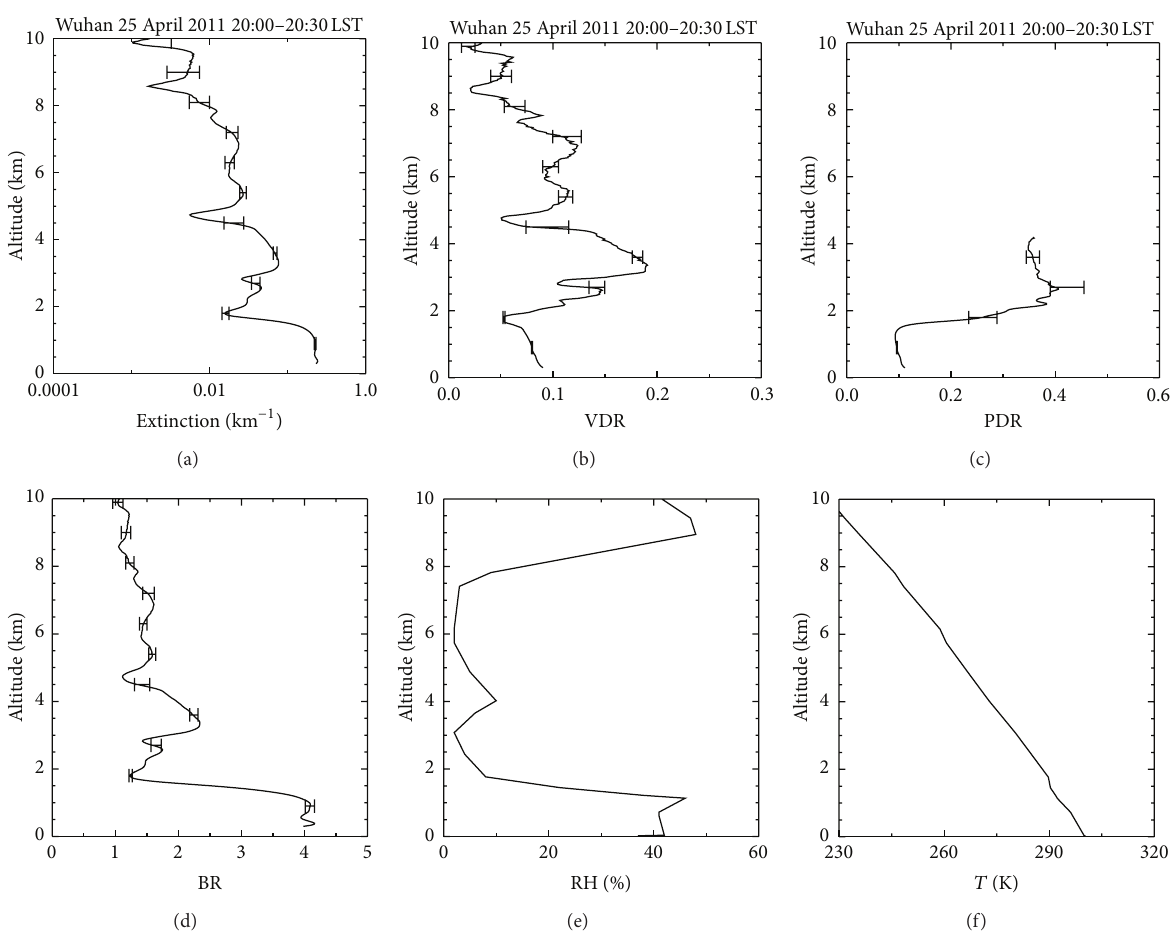
Figure4: Profiles of(a) aerosolextinction, (b)volumedepolarization ratio, (c)particle depolarization ratio, (d)backscattering ratio measured using the depolarization lidar, (e) relative humidity, and (f) temperature measured using radiosonde during the half hour of 20:00–20:30 LST on 25 April 2011. The error bars represent the standard